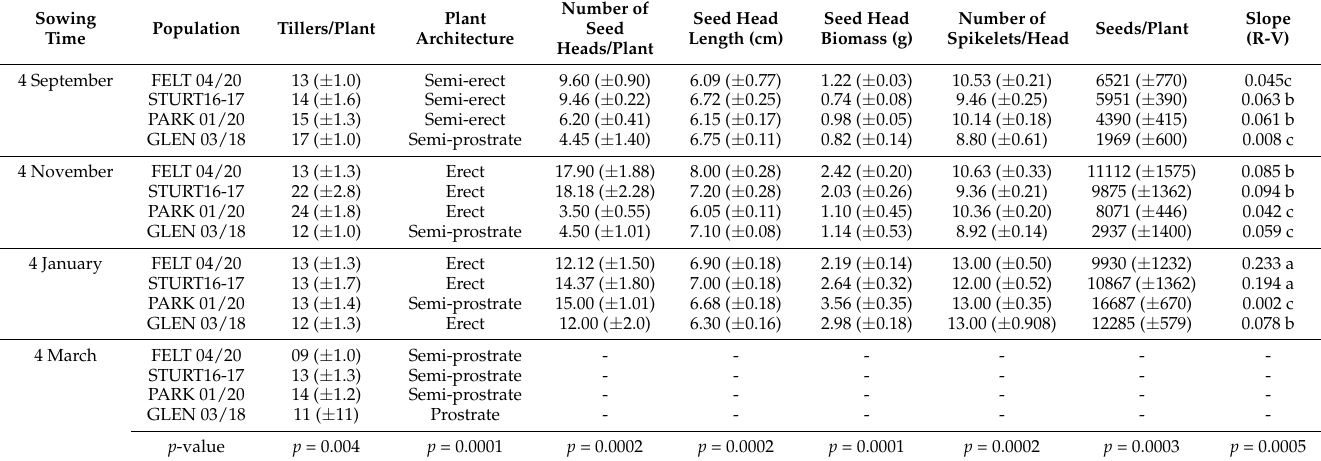
Table 5. Effect of sowing time on tiller number, plant architecture, seed head number, seed head length, seed head biomass, number of spikelets per seed head, seeds per plant, and the relationship slope between the reproductive biomass and the vegetative biomass (R-V) of four different populations of feathertop Rhodes